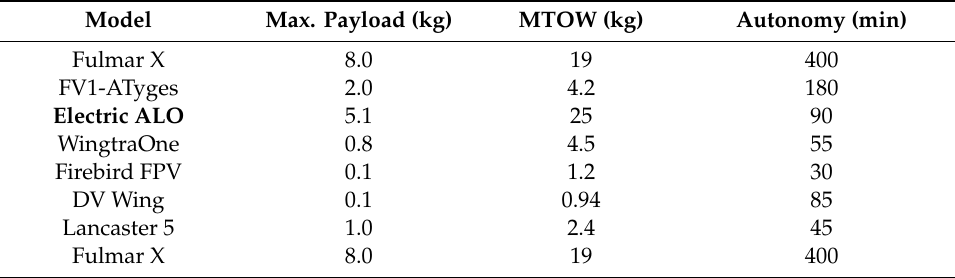
Table 12. Comparison of some commercial fixed-wing UAVs with the electric